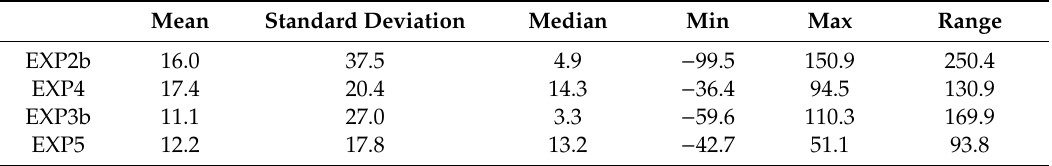
Table 17. SHF (W m − 2 ) simulated by UTOPIA and NOAH, initialized with GLDAS, at the FB station. Mean Standard Deviation Median Min Max Range